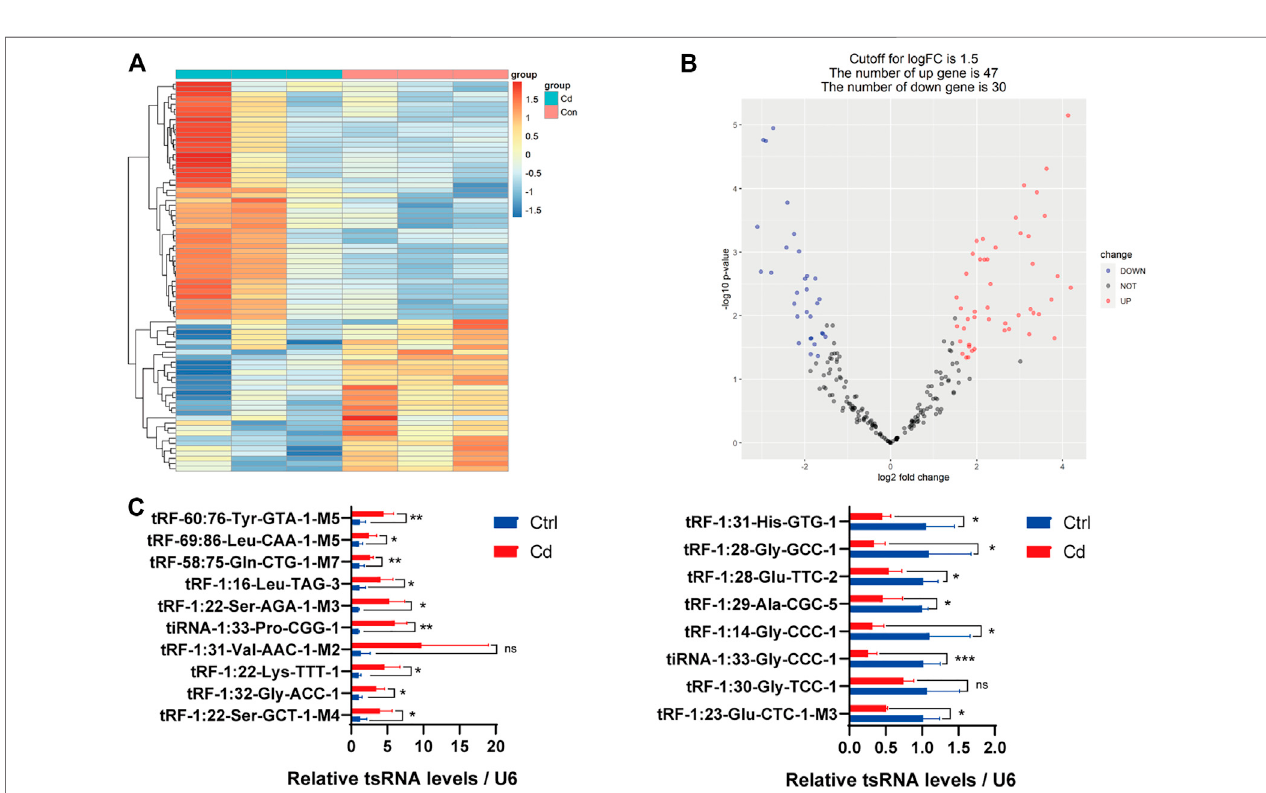
FIGURE3| Differential expression analysisoftsRNAs betweenthetwogroups. (A) The heat-map forthedifferentially expressed tsRNAs between thetwogroups. The color in the panel represents the relative expression level (log2-transformed). The colored bar at the top panel shows the different groups. (B) The volcano plot is constructed by plotting -log10 ( p -value) on the y -axis, and tsRNAs expression log2 (fold change) between the two experimental groups on the x -axis, providing a visualization method to perform a quick visual identi fi cation of the differentially expressed tsRNAs. (C) The validation of the 10 up-regulated tsRNAs and 8 down- regulatedtsRNAsusingqRT-PCR,respectively( n (cid:1) 6).Allresultsareexpressedasthemean ± SD.Labeledasteriskrepresentsstatisticalsigni fi cancecomparedwiththe respective control group. * p < 0.05, ** p < 0.01 and *** p < 0.001. ns, no signi fi cant difference.